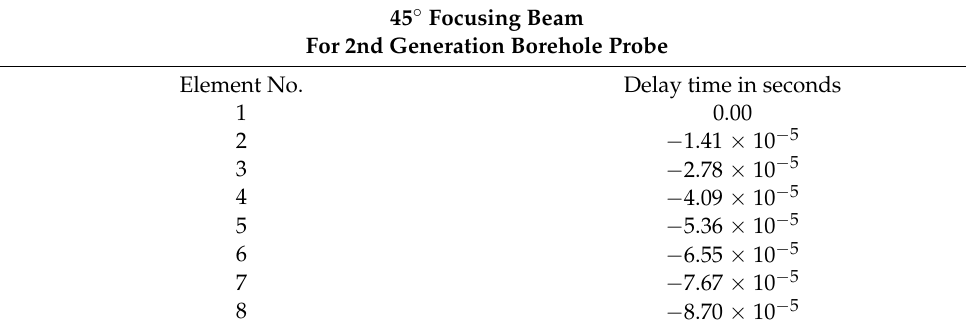
Table A1. Calculated delay time for second generation borehole probe.